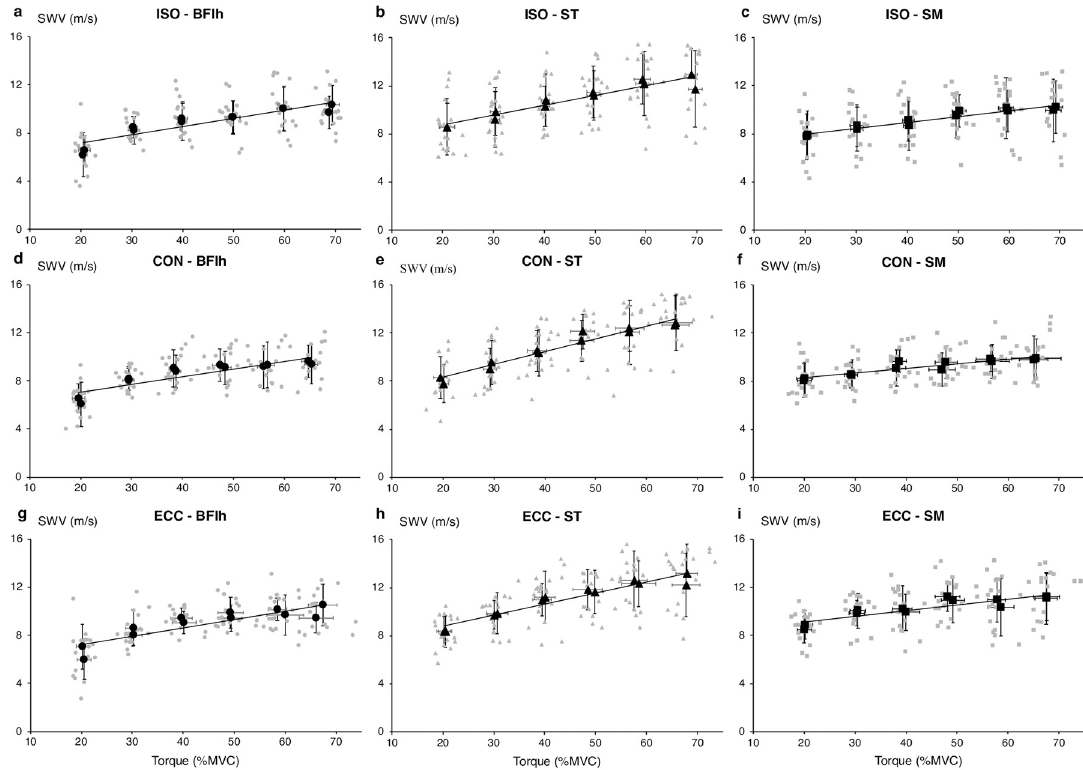
Fig 1. Hamstrings shear wave velocity–torque relationship. Hamstrings shear wave velocity (SWV)–torque relationship in absolute values for isometric (ISO, panels a-c), concentric (CON, panels d-f) and eccentric (ECC, panels g-i) conditions. The grey markers correspond to all duplicate contractions and the black markers correspond to the group average (SD) for each set of the duplicate contractions. The black lines correspond to the linear regressions fitted to the group averages. BFlh, biceps femoris long head; ST, semitendinosus; SM,